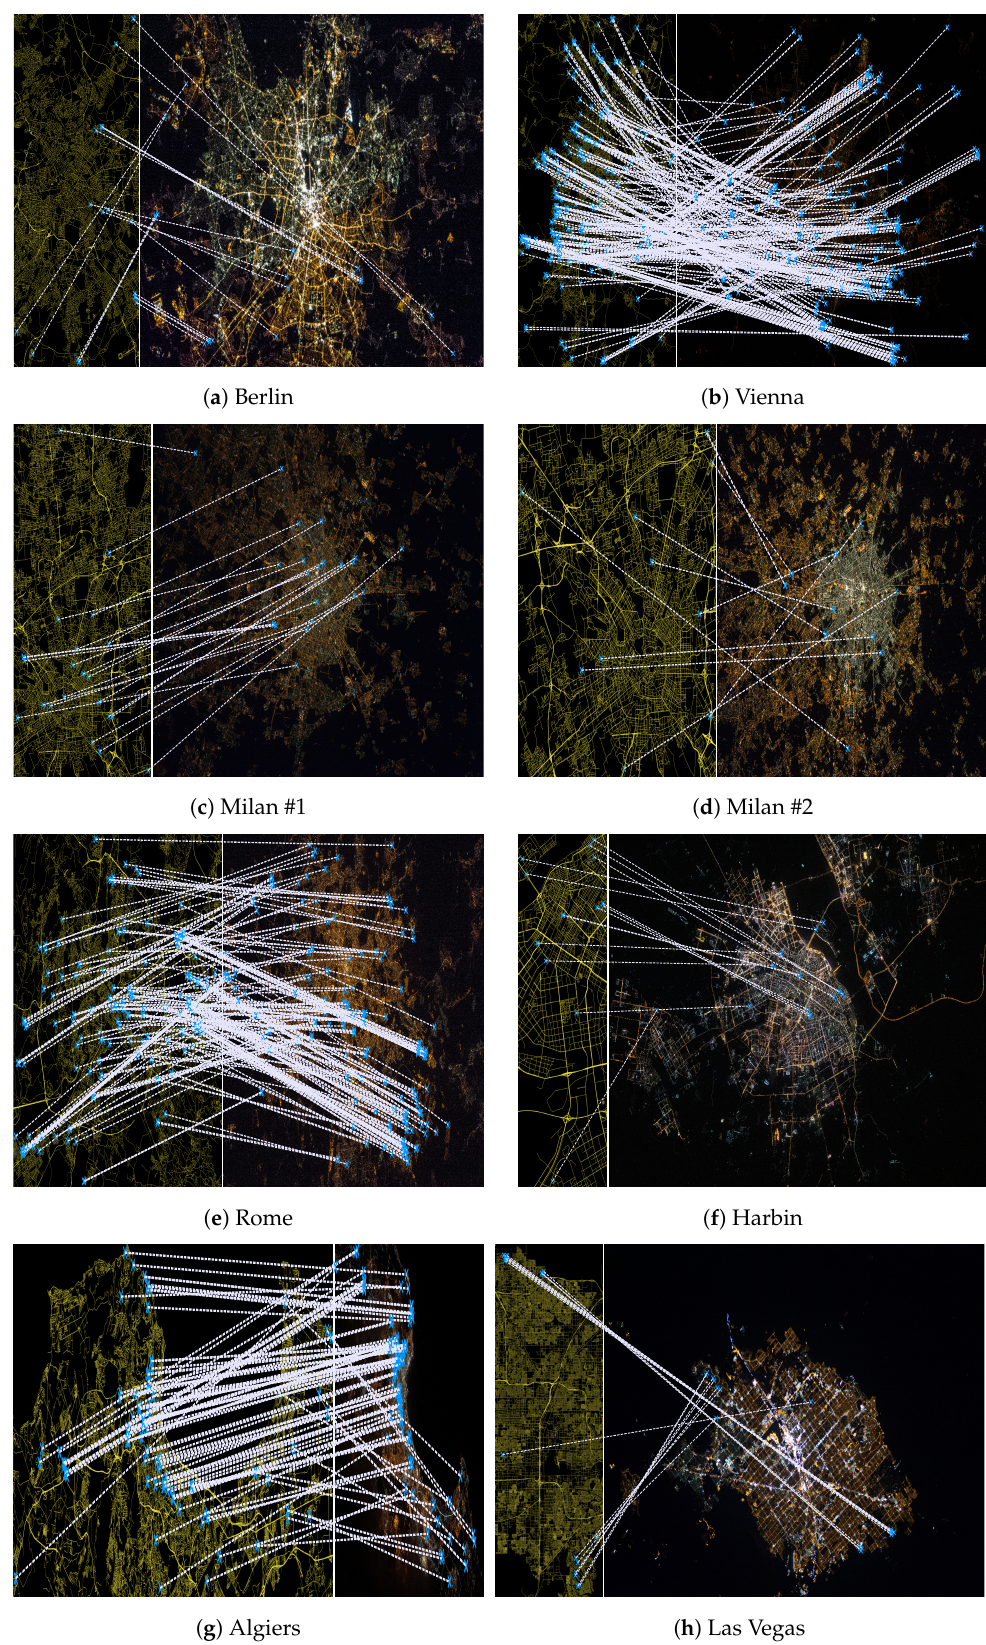
Figure 10. Filtered matches obtained for datasets. For each dataset, a subsection of the reference image containing all identified matches is shown on the left, and the complete NTL photo is shown on the